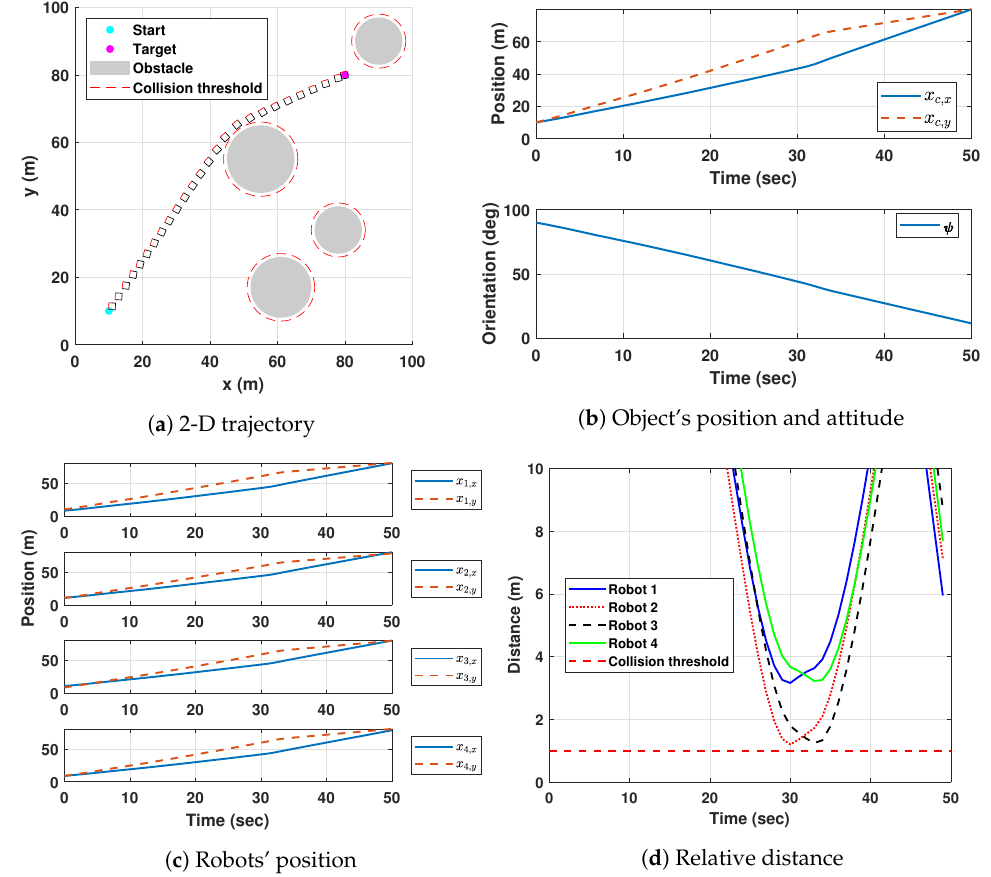
Figure 7. Optimization results: Scenario